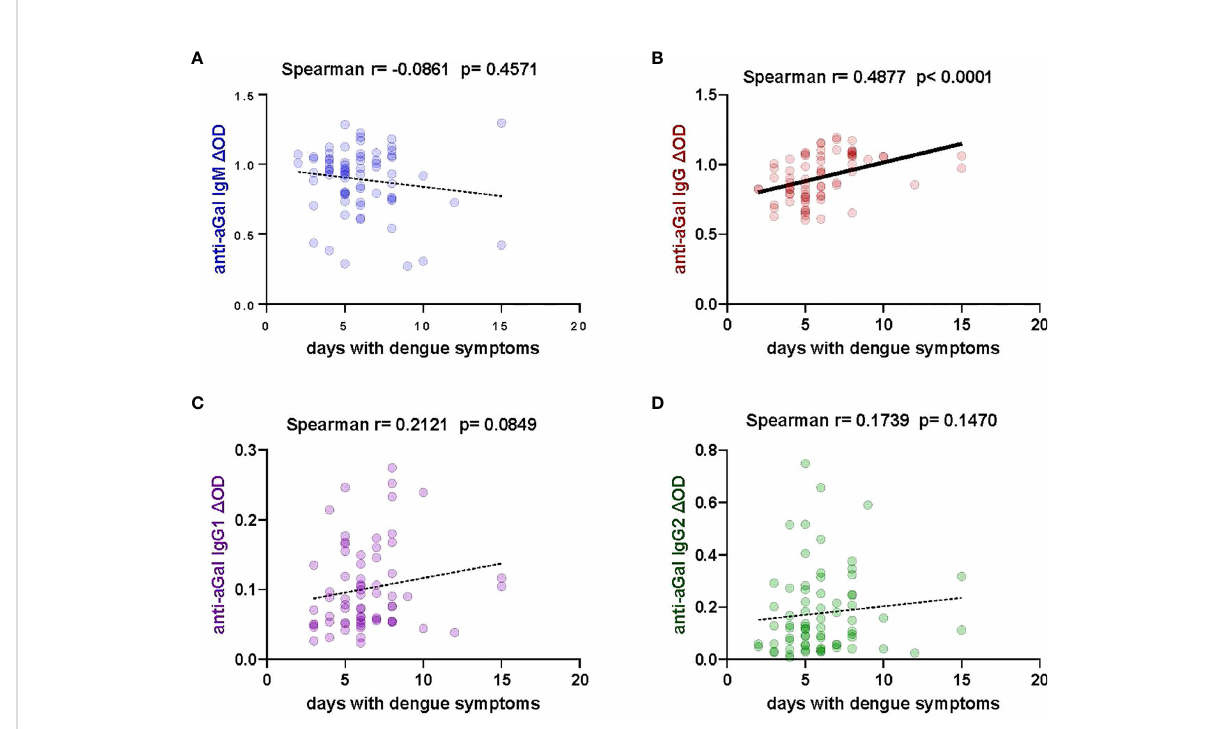
FIGURE 4 Correlation of speci fi c anti- aGal IgM, IgG, IgG1, and IgG2 antibody levels and days with dengue symptoms in patients. (A) Blue color - anti-aGal IgM antibody levels. (B) Brown color - anti-aGal IgG antibody levels. (C) Purple color - anti-aGal IgG1 antibody levels. (D) Green color - anti- aGal IgG2 antibody levels. Regression lines in each graph are shown by solid lines for p<0.05 and dotted lines for non-signi fi cant correlations. Antibody levels are measured in units of OD (optical density). “ r ” and “ p ” values were measured using the pairwise non-parametric Spearman correlation